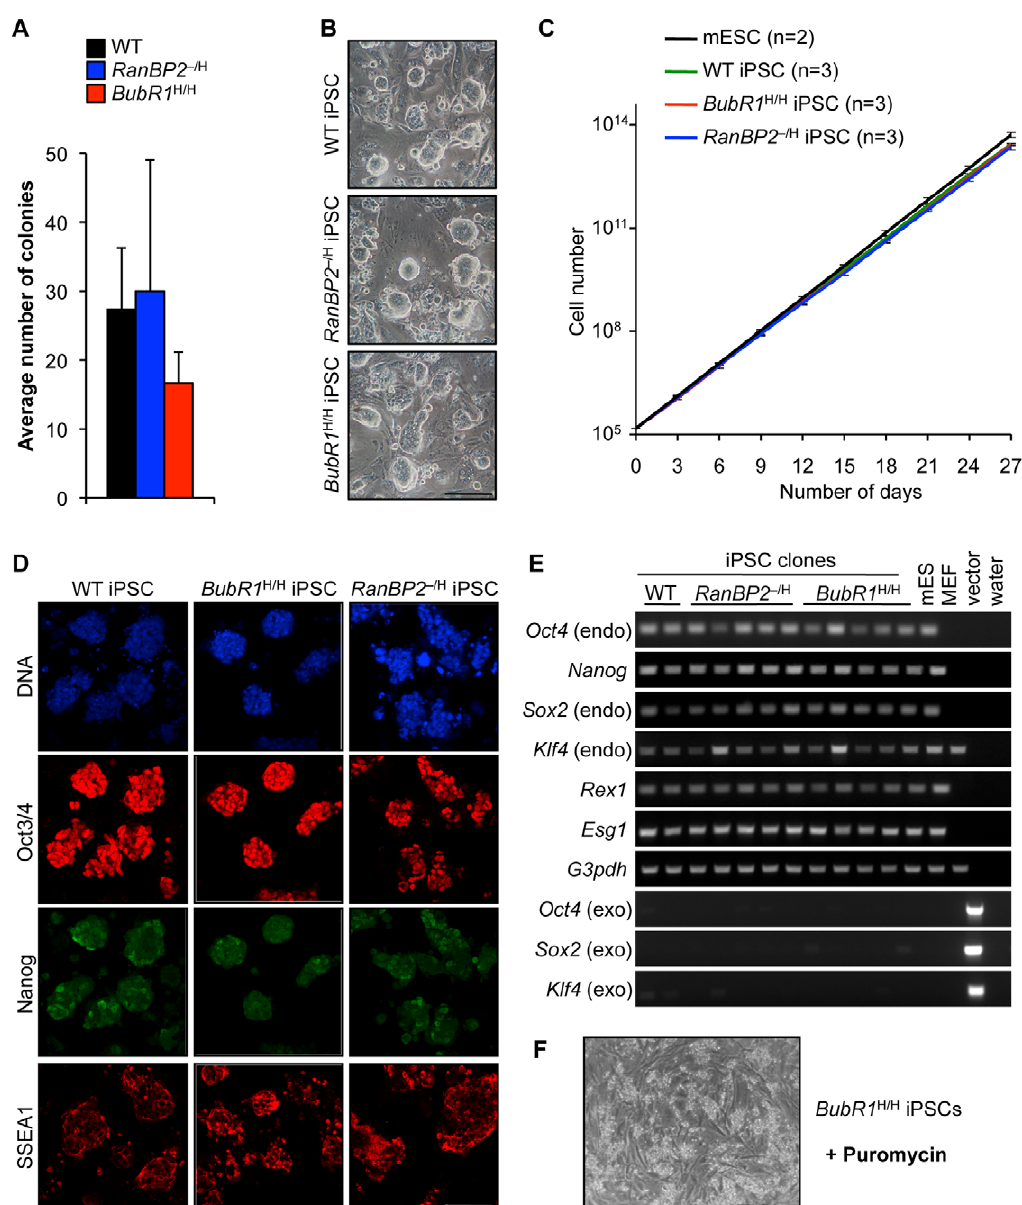
Figure 1. MEFs with W-CIN gene mutations can be efficiently reprogrammed into iPSCs. (A) Average numbers of ES cell-like colonies derived from MEFs with indicated genotypes (n=3 independent MEF lines). Error bars represent SEM. (B) Light microscopy images of iPSC colonies with indicated genotypes growing on SNL feeder layer. Scale bar represents 500 m m. (C) Growth curves of mESCs and iPSC clones derived from MEFs of the indicated genotypes. We note that there were no significant differences in growth between individual iPSC lines of each genotype. Error bars represent SD. (D) Immunostaining of wildtype, RanBP2 –/H and BubR1 H/H iPSC for ES cell markers. Representative images are shown. DNA of cells stained for Oct3/4 and Nanog was visualized with Hoechst. Scale bar represents 200 m m. (E) RT-PCR analysis of retroviral transgene silencing and endogenous pluripotency-associated gene induction. (F) Silencing of retroviral expression after direct reprogramming. BubR1 H/H iPSCs die upon addition of 4 m g/ml puromycin for 24 h. Scale bar represents 500 m m.